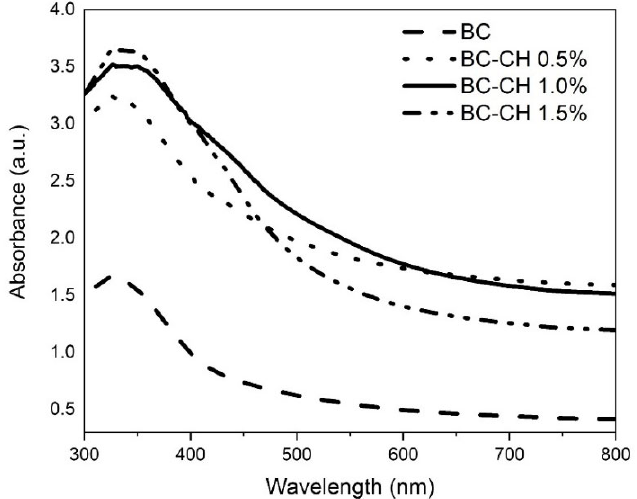
Figure 8. UV-Visible spectra of BC and BC-CH films coated with various concentrations of Figure 8. UV ‐ Visible spectra of BC and BC ‐ CH films coated with various concentrations of chitosan.